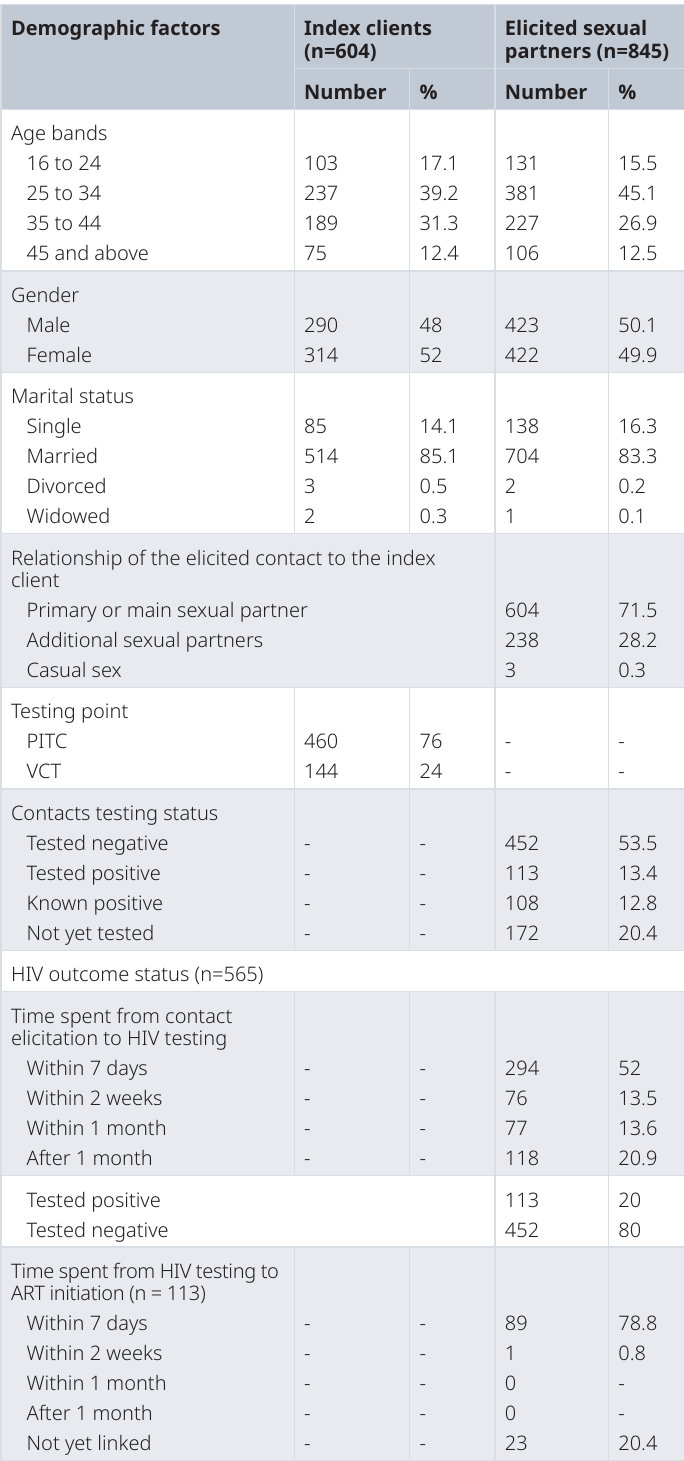
Table 2. Socio-demographic characteristics of index clients and other characteristics of their referred sexual partners, Matero, Zambia, October to December